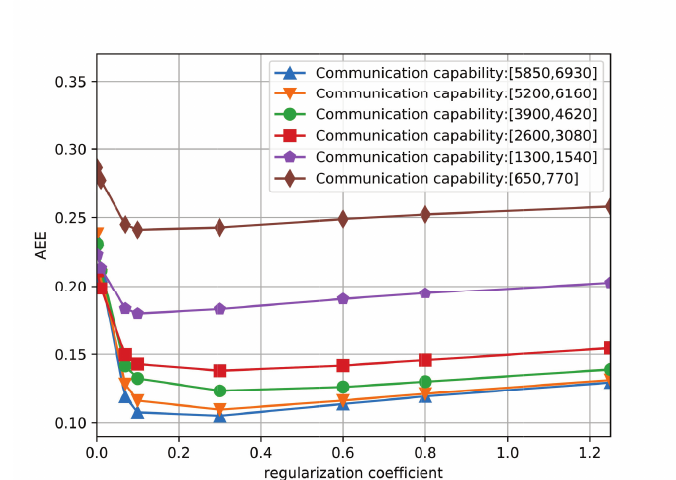
Figure 6. The AEE of the proposed algorithm under different regularization